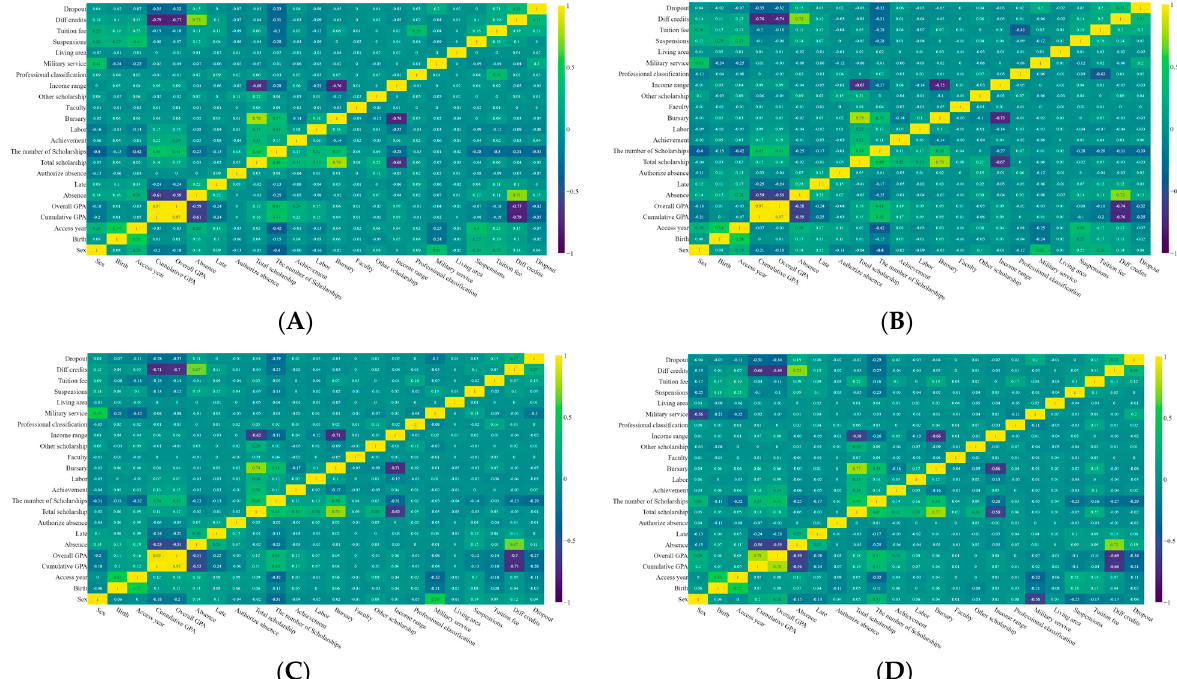
Figure 1. The heat map based on ( A ) the mean value-based feature table, ( B ) the median value-based feature table, ( C ) the first-semester data-based feature table, and ( D ) the final semester data-based feature table.